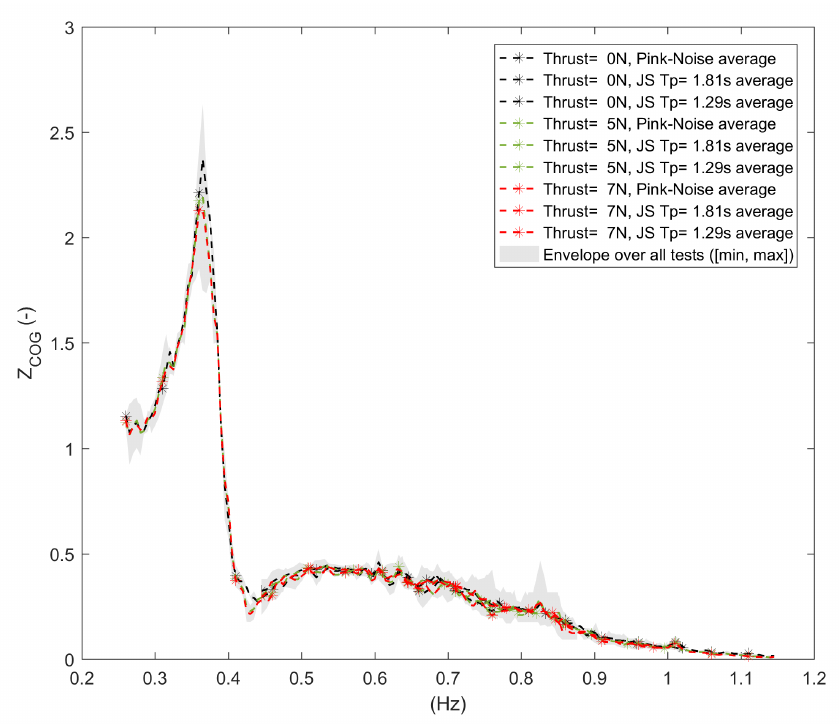
Figure 23. Heave RAOs for all irregular waves: average and envelop (min and max).